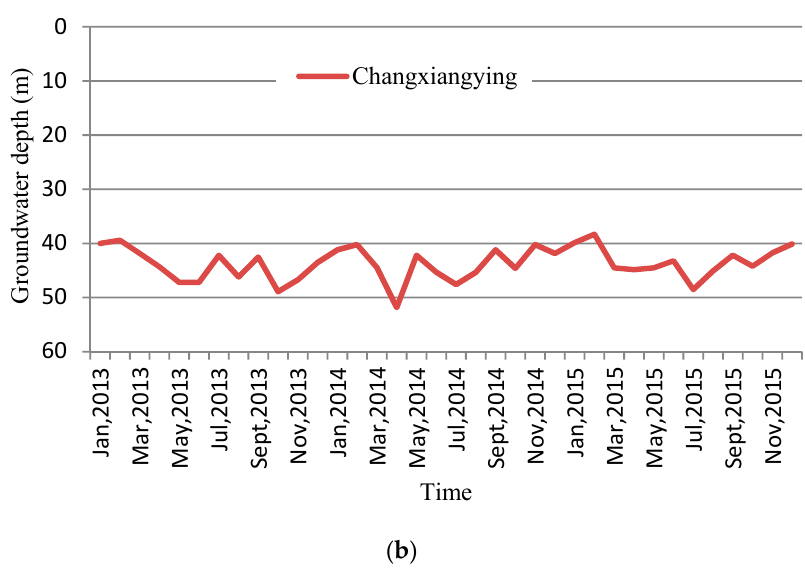
Figure 5. Comparison of the groundwater depth before and after treatment in the project areas. ( a ) The well-logs in Baisiying and Zhanghedian Townships as well as Shangcheng Town; ( b ) The well-log in Changxiangying Township.